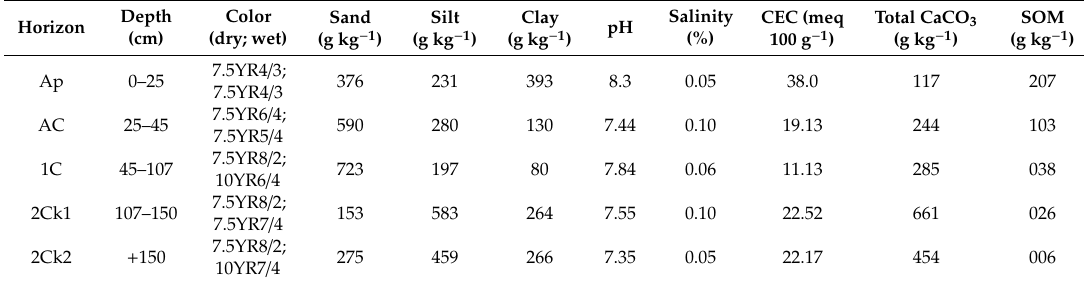
Table 1. Soil profile characteristics and some